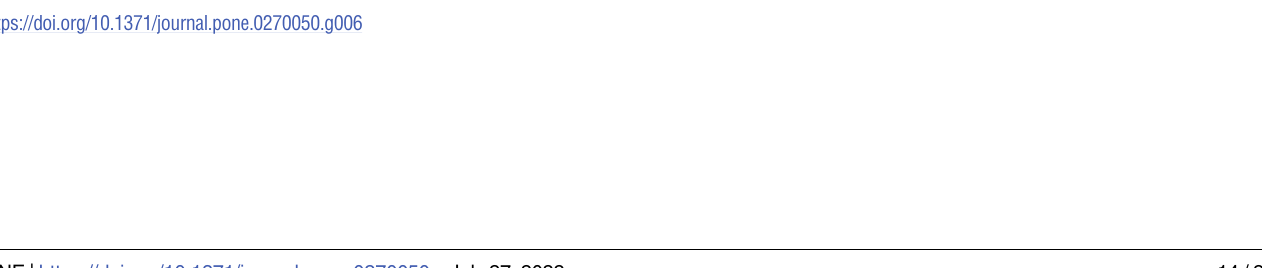
PLOS ONE | https://doi.org/10.1371/journal.pone.0270050 July 27,